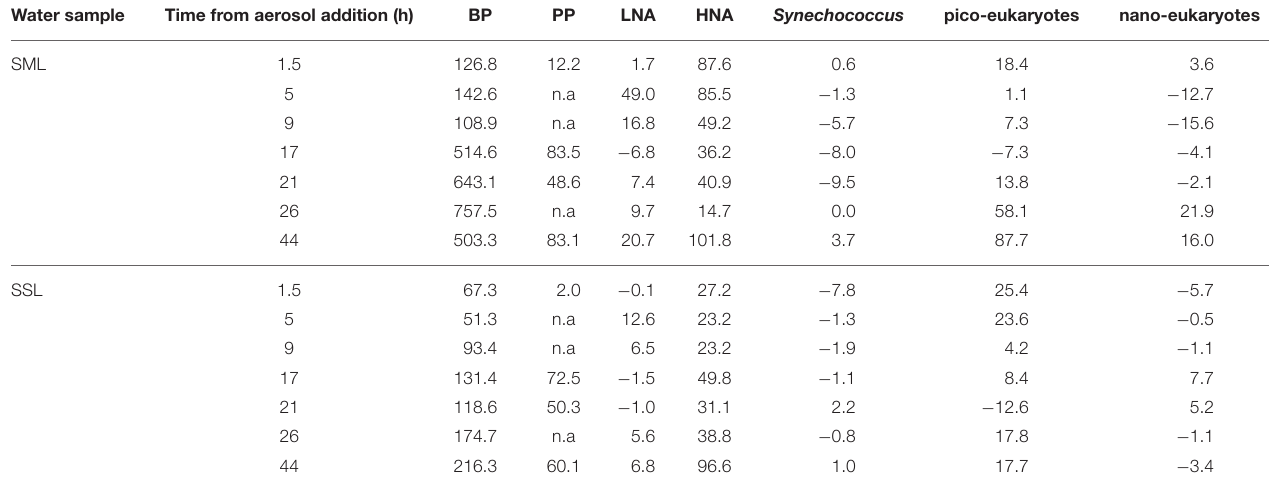
TABLE 3 | Summary of the net change (%) observed following aerosol addition (1.5mg L − 1 ) in the SML and the SSL microcosms relative to unamended controls. Water